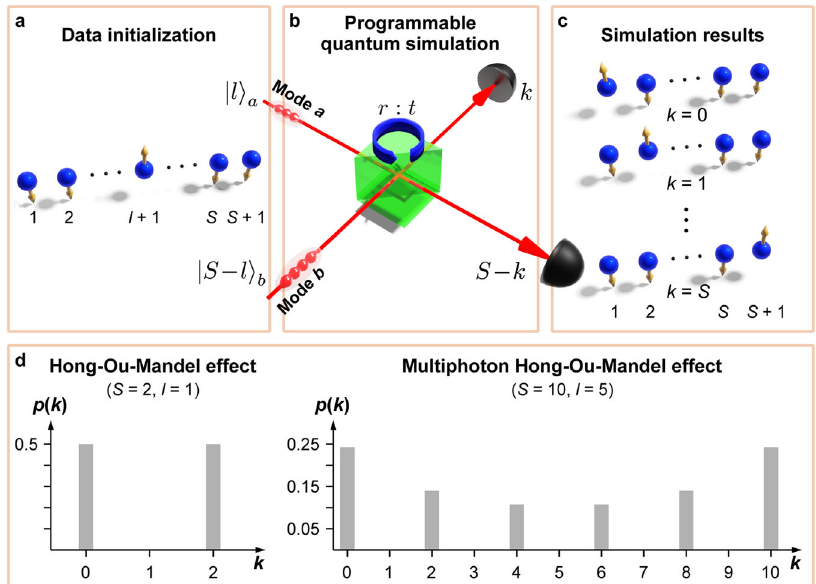
Fig. 1 Photonic quantum simulations with Fock state interference. a Fock states l j i chain with S + 1 sites. b A beam splitter with re fl ectivity r models an XY-type of interaction in the chain that lasts 2arcsin of detecting k and S − k photons in its output ports p ( k ), simulates the excitation probability of the k th spin in the chain as a result of the interaction. d The statistics p ( k ) originates from fundamental indistinguishability of several scenarios that occur to interfering Fock states which classically are exclusive but quantum-mechanically are coexisting, and amount to the same partitioning of incoming photons into two exit ports. Events for which quantum probability amplitudes add up non-destructively are registered more often than